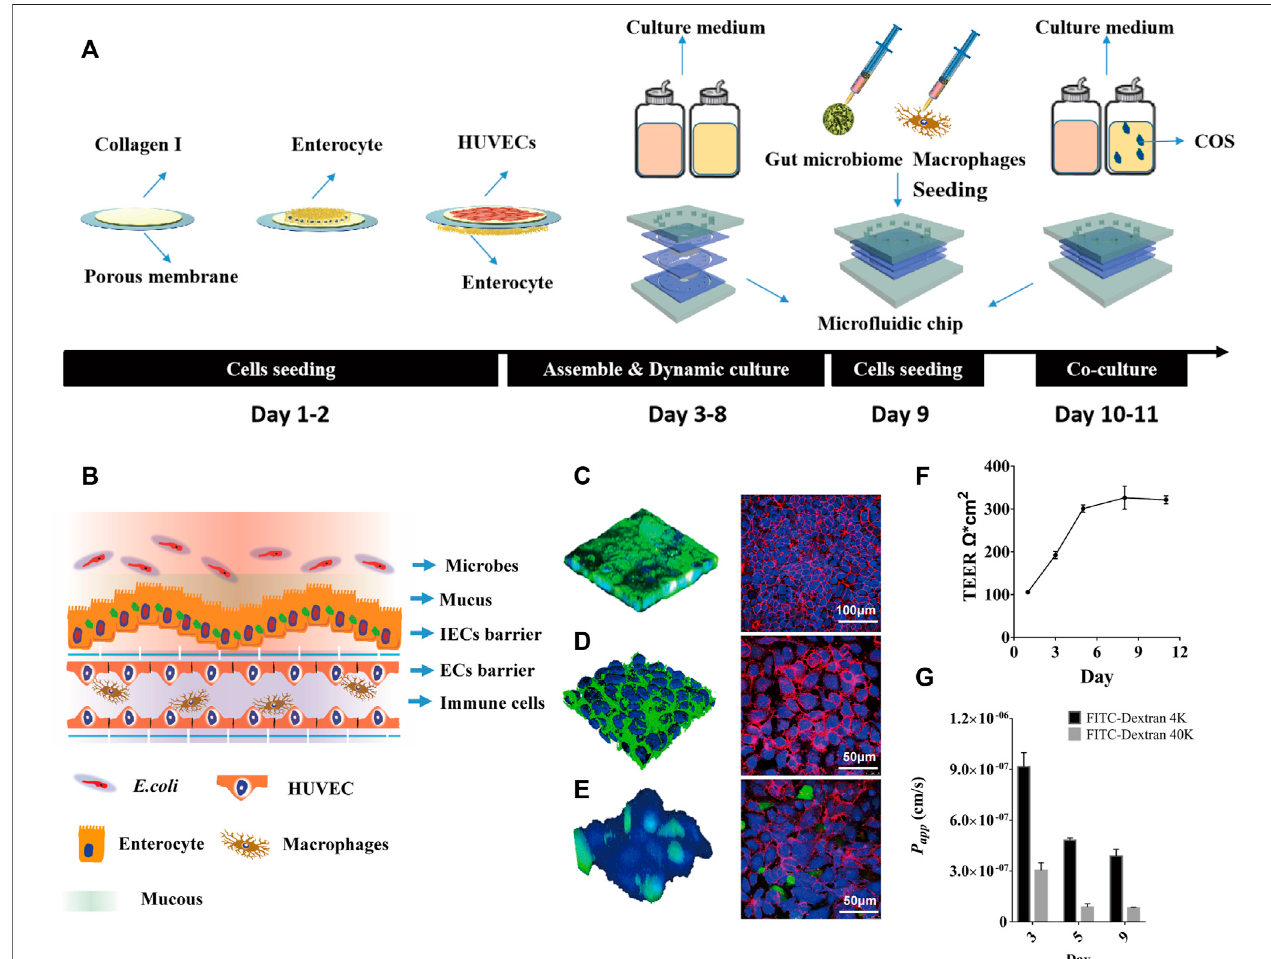
FIGURE1| Thehumanin fl ammatoryboweldiseasemodelonachip. (A) Diagrammaticoverviewoftheconstructionprotocolofin fl ammatoryboweldiseasemodel on a chip. (B) Schematic diagram ofhuman gut-on-a-chip with microbes, mucus, intestinal epithelial cells (IECs) barrier, endothelialcells (ECs) barrier and immunecells. (C) Intestinalmucinstainingusingwheatgermagglutinin(WGA)labeledwithFITC(Left,Green),andimmuno fl uorescencestainingagainstoccludinonintestinalepithelial cells (Right, Red); (D) Vascular endothelial glycocaly staining using WGA-FITC (Left, Green), and immuno fl uorescence staining against CD144 (VE-cadherin) on endothelial cells (Right, Red). (E) Macrophages (Green) adhering to the vascular endothelial cells (Blue) surface, and immuno fl uorescence staining against CD31 (PECAM-1) on endothelial cells (Right, Red). (F) TEER values of IECs co-cultured with HUVECs on the chip for 11 days. (G) The P app value of FITC-labeled dextran (4 kDa, 40 kDa) through IECs co-cultured with HUVECs on the chip.